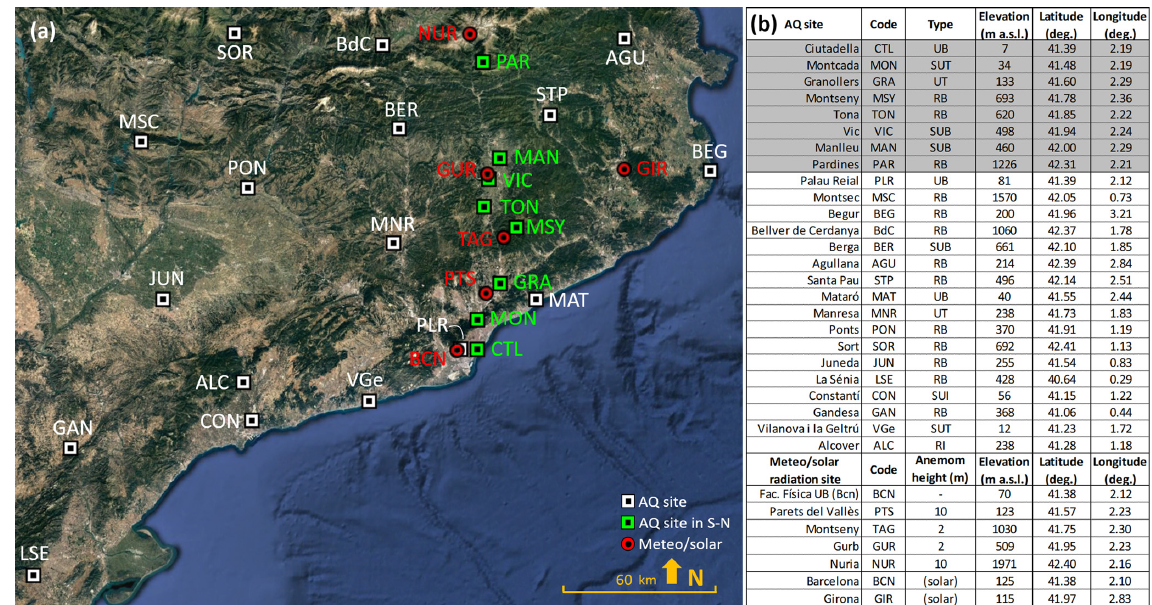
Figure 2. Location (a) and main characteristics (b) of the selected air quality monitoring sites (S–N axis: green squares on the map and shaded gray on the table; rest of the stations: white squares) and meteorological/solar radiation stations (red circles) selected for this study. Types of air quality monitoring sites are urban (traffic or background: UT, UB), suburban (traffic, industrial or background: SUT, SUI, SUB) and rural (background or industrial: RB, RI). PLR (Palau Reial air quality monitoring site) and BCN (Barcelona) meteorological and solar radiation sites are closely